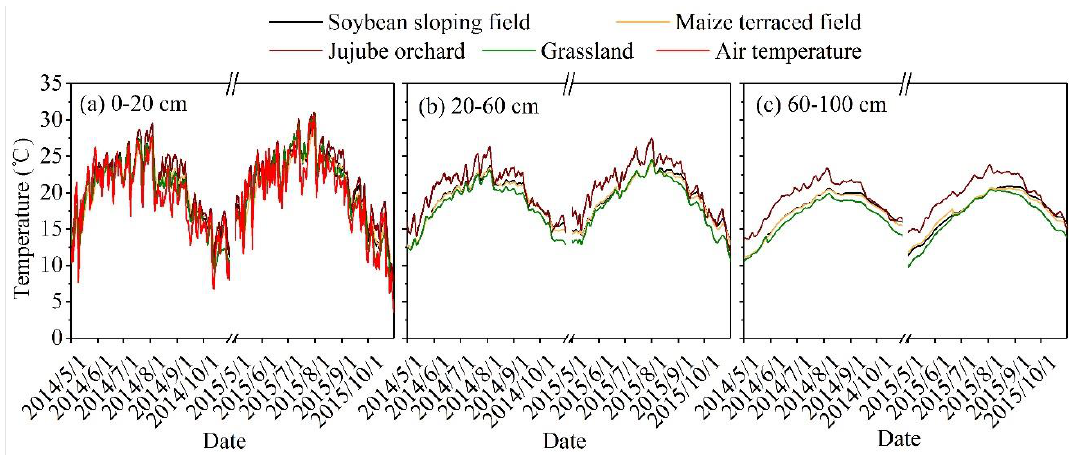
Figure 4. Dynamics of daily average soil temperature in ( a ) 0–20 cm, ( b ) 20–60 cm, and ( c ) 60–100 cm soil layers under different sloping land uses during the 2014 and 2015 growing seasons.